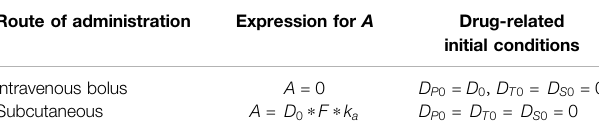
TABLE 2 | Expressions for A depending on route of drug